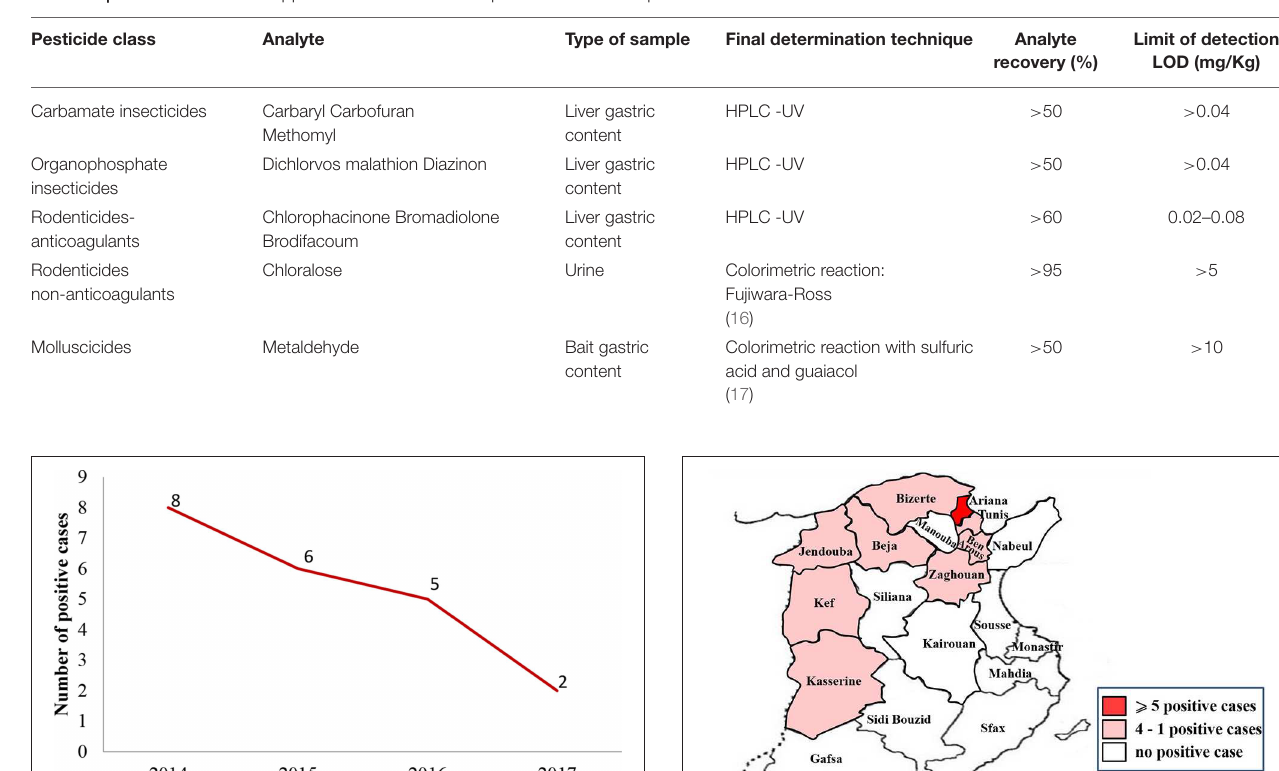
TABLE 1 | Information’s lists on applied determination techniques for different samples.